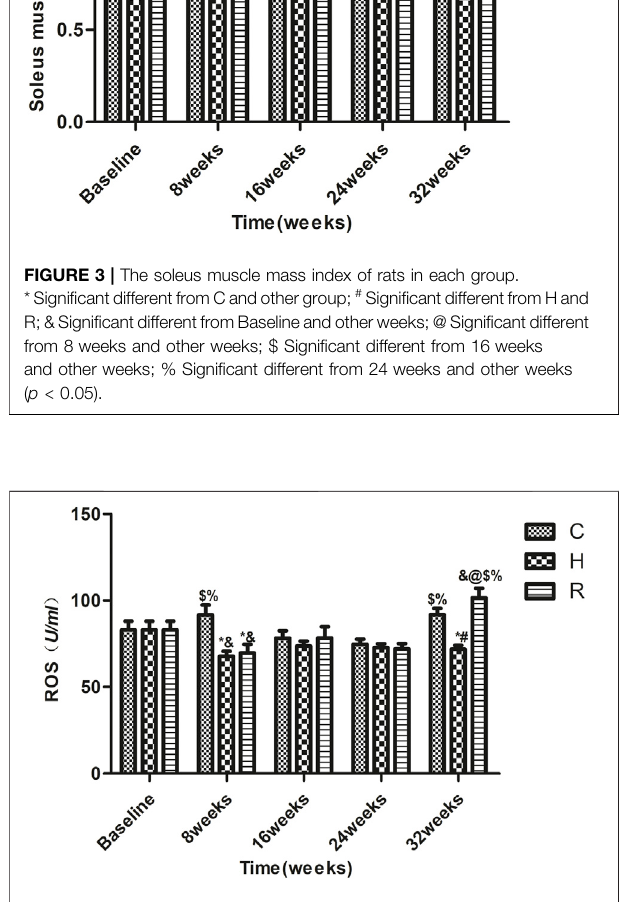
FIGURE 4 | The ROS level of soleus muscle in each group. * Signi fi cant different from C and other group; # Signi fi cant different from H and R; & Signi fi cant different from Baseline and other weeks; @ Signi fi cant different from8 weeksandotherweeks;$Signi fi cantdifferentfrom16weeksand other weeks; % Signi fi cant different from 24 weeks and other weeks. ( p <